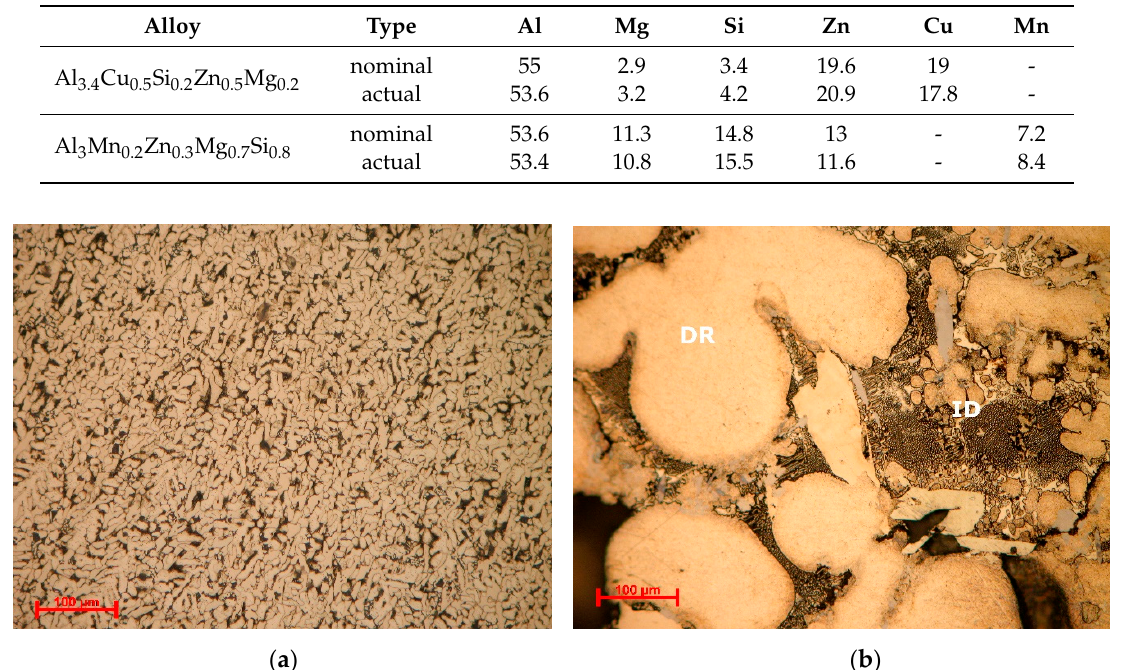
Figure 12. Optical micrographs of ( a ) as-cast and ( b ) annealed Al 3.4 Cu 0.5 Si 0.2 Zn 0.5 Mg 0.2 alloy. DR-dendritic area, ID-interdendritic area.